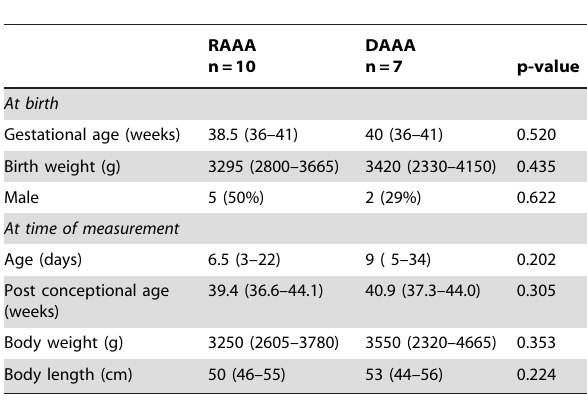
Table 1. Comparison of patient characteristics of infants with right-sided (RAAA) and double-sided aortic arch anomaly (DAAA) (presented as median (range) or n (%)).